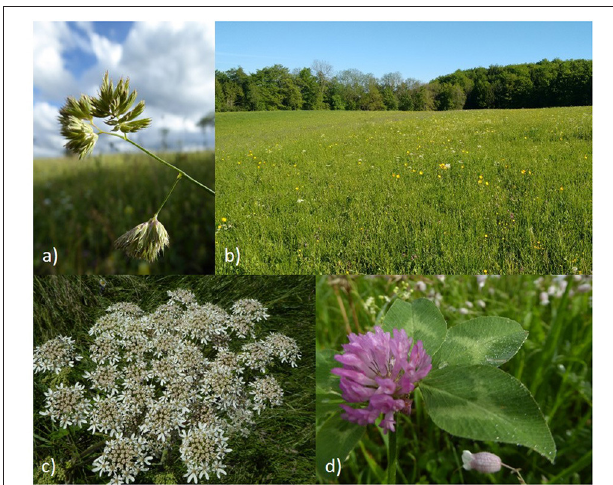
FIGURE 2 | Pictures of the studied species [ D. glomerata (a) , H. sphondylium (c) , and T. pratense (d)] and study site 01, as an example of a typical study site. Pictures were taken by EP (b) and TL (a,c,d) during sampling.